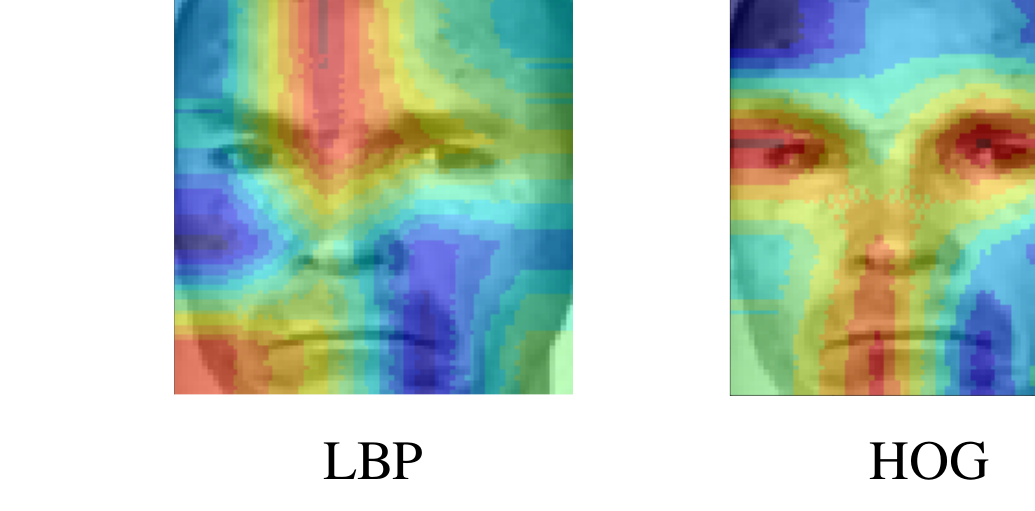
Figure 12. Most important zones of the faces for